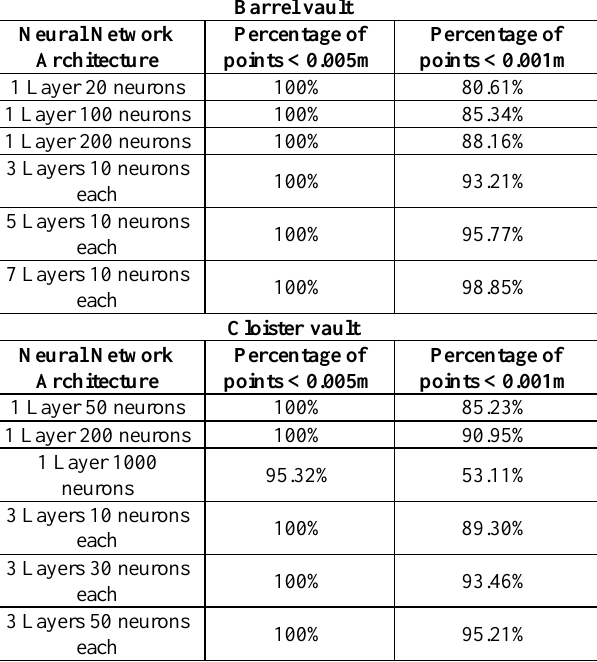
Table 2. “Barrel Vault” and “Cloister vault” data set